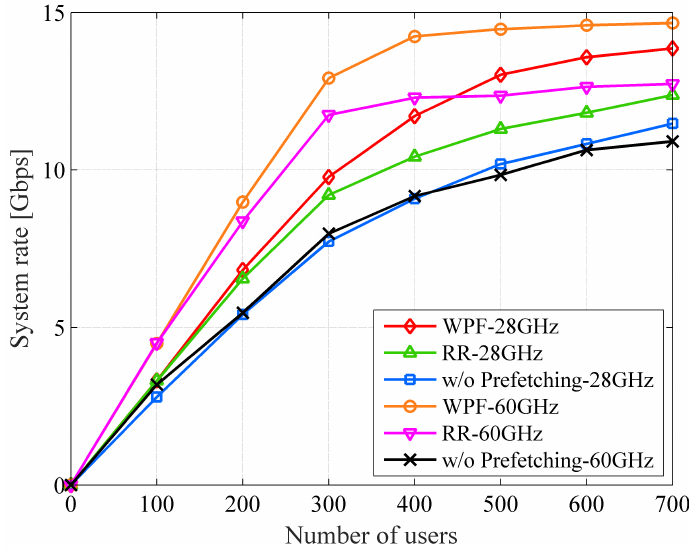
Figure 10. The system rate vs. the number of users (1 Gbps backhaul capacity and 500 s time window).